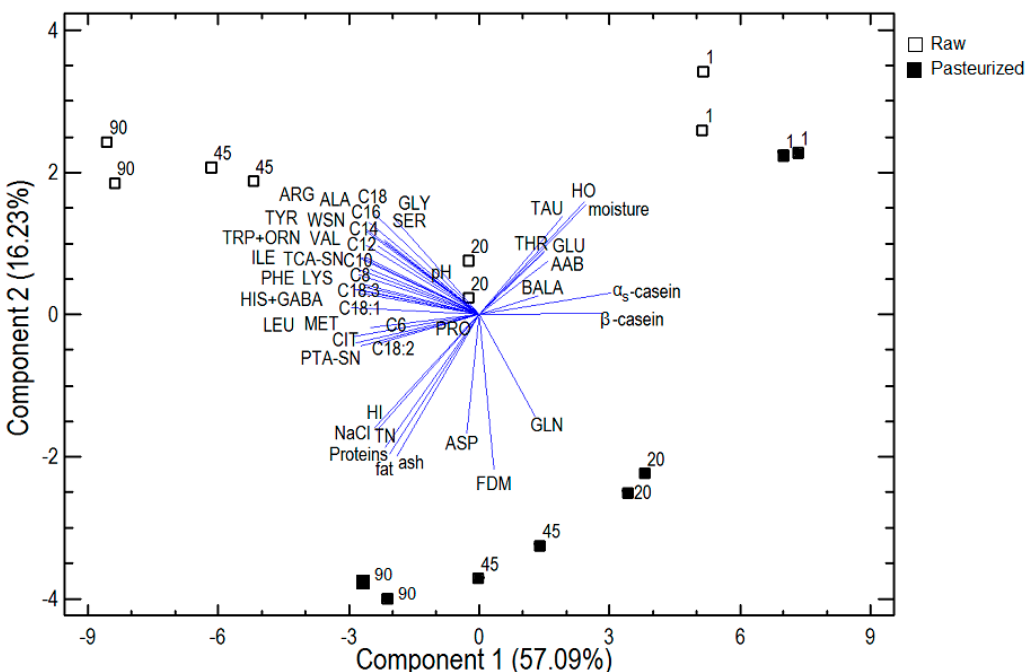
Figure 3. Principal component analysis. Plot of the two first principal